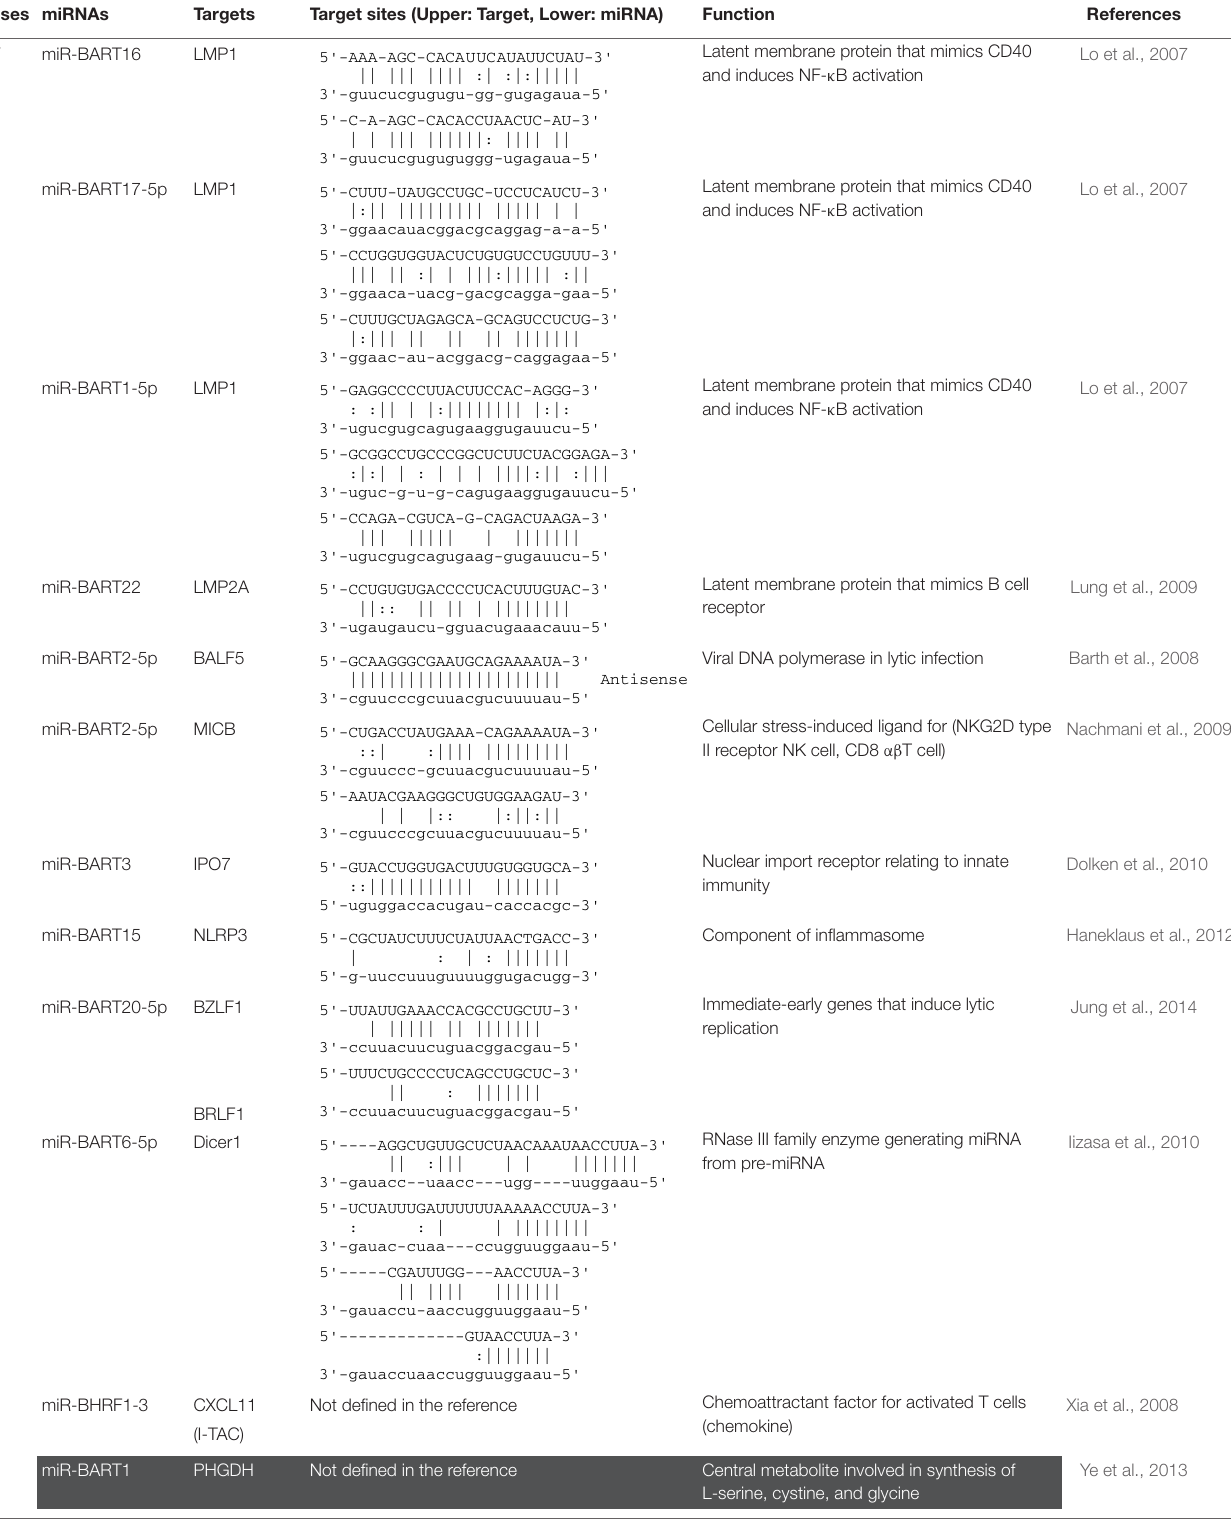
TABLE 1 | The role of herpes virus-encoded miRNAs in immune evasion and cancer metabolism. Viruses miRNAs Targets Target sites (Upper: Target, Lower: miRNA)